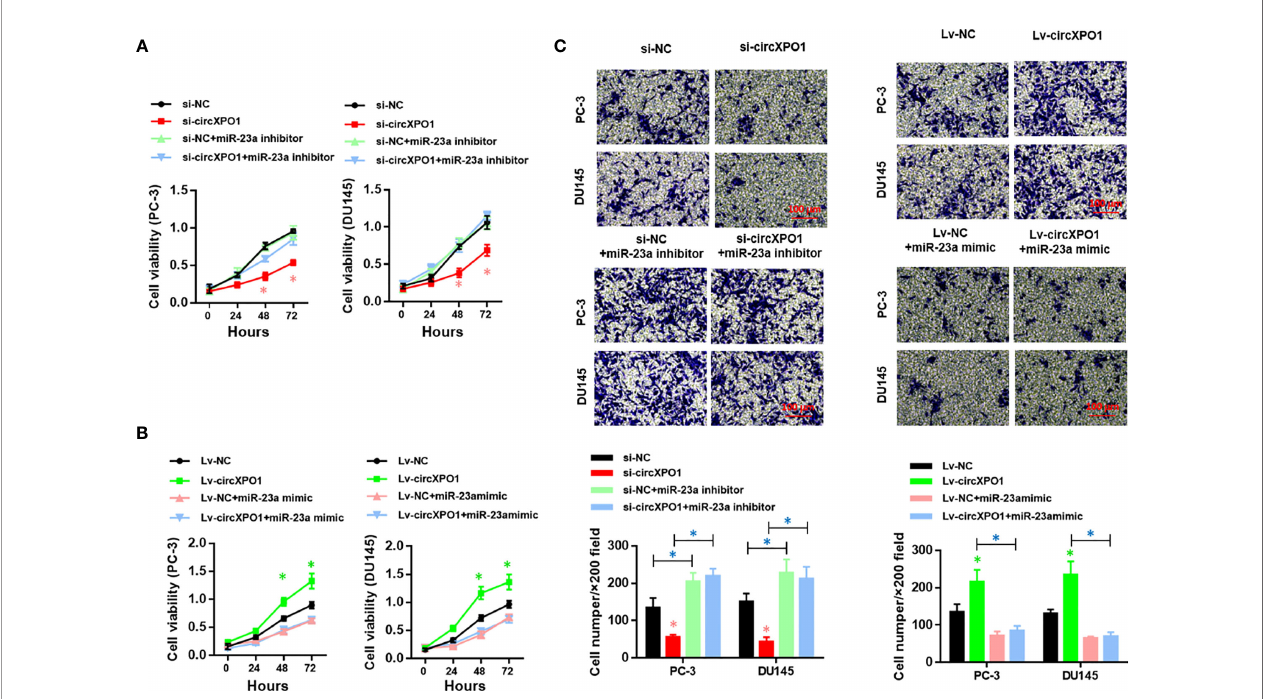
FIGURE 4 | circXPO-1 promoted cell proliferation, migration, and invasion of prostate cancer cells by sponging miR-23a in vitro . PC-3 or DU145 cells were transfected as indicated. CCK-8 assay (A, B) and trans-well assay (C) were carried out to examine cell proliferation, migration, and invasion. Data are expressed as the means ± SD. * P < 0.05; n =